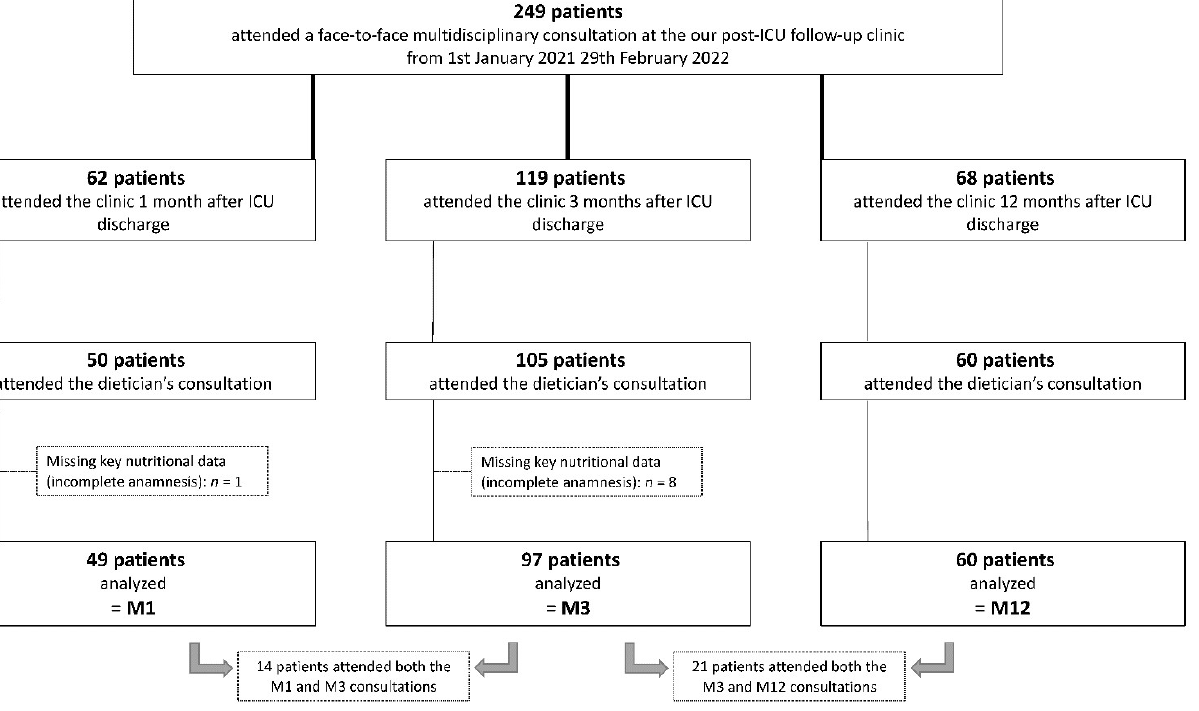
Table 1. Patients’ characteristics at the three